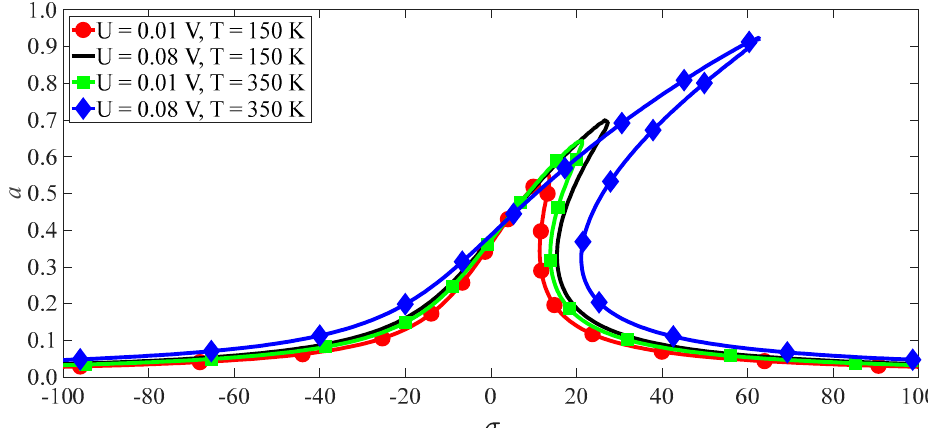
Figure 6. Frequency − response curves of the first mode with ( c 1 , f 1 ) = ( 5,4.95 ) .